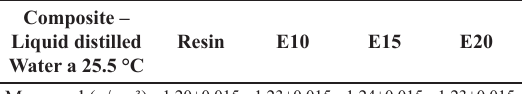
Table 3. Resin otho-theraftalic density.